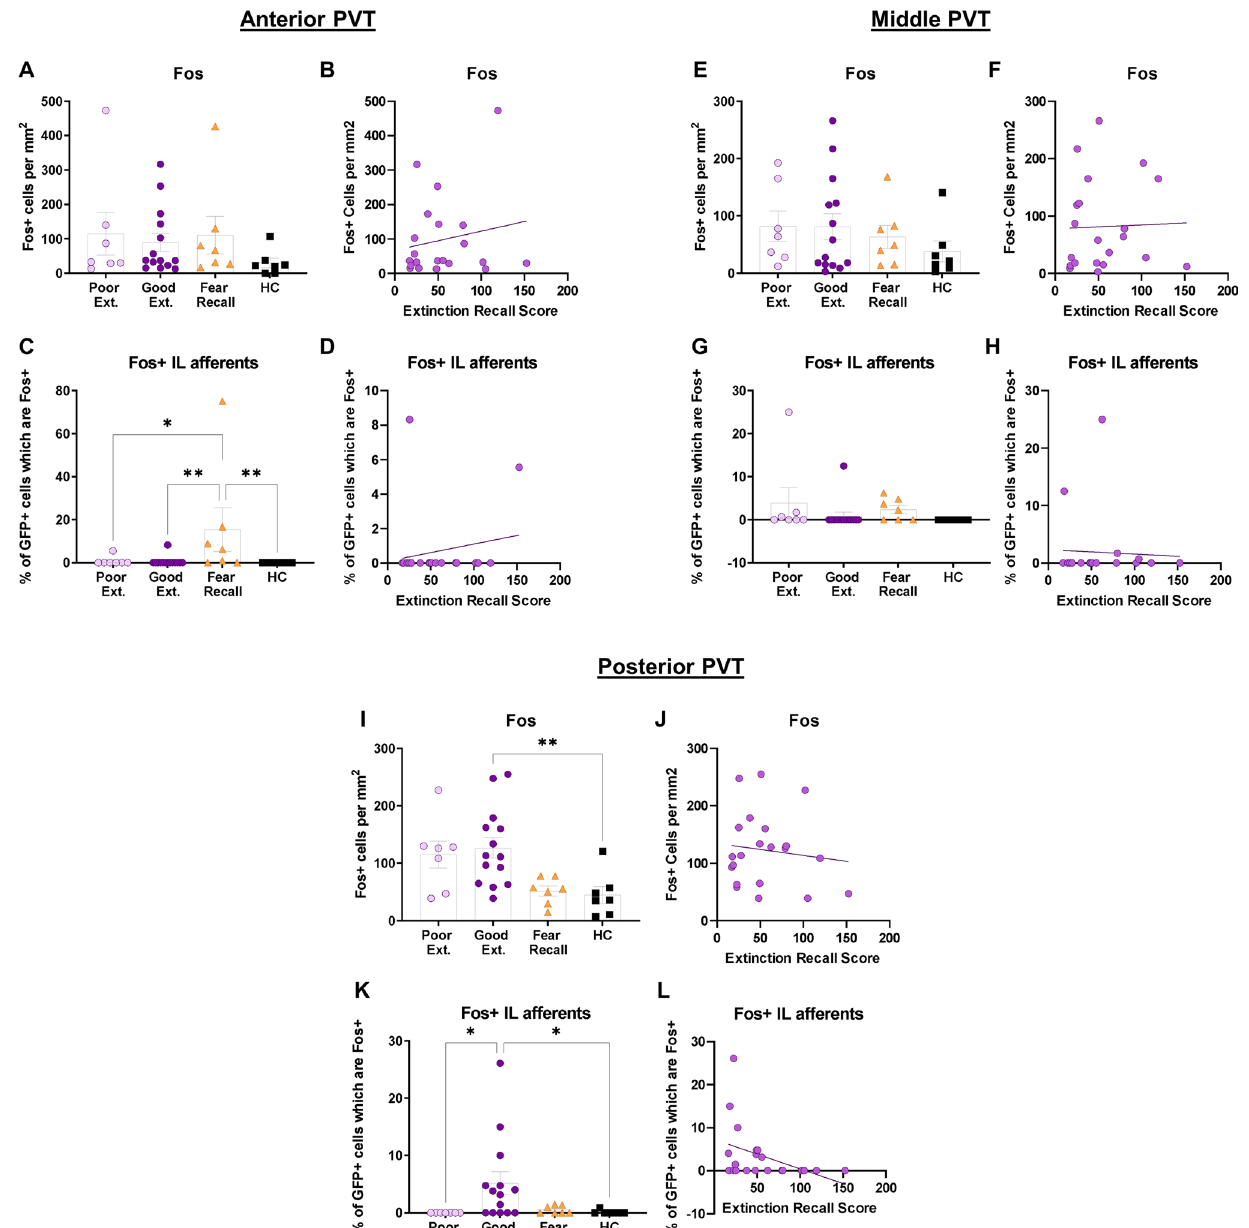
Figure 4. Fos activity is elevated in the IL-afferents of the posterior paraventricular thalamus (PVT) in rats displaying good extinction. ( A ) No significant differences among groups in Fos expression in the aPVT. ( B ) No significant correlation between Fos expression and extinction recall in the aPVT. ( C ) Fear recall group showed elevated Fos expression within IL-afferents relative to all other groups. ( D ) No significant correlation between Fos expression within IL-afferents and extinction recall in the aPVT. ( E ) No significant differences among groups in Fos expression in the mPVT. ( F ) No significant correlation between Fos expression and extinction recall in the mPVT. ( G ) No significant differences among groups in Fos expression within IL-afferents in the mPVT. ( H ) No significant correlation between Fos expression within IL-afferents and extinction recall in the mPVT. ( I ) Good extinction group, but no other groups, shows elevated Fos activity in the pPVT relative to the home cage group. ( J ) No significant correlation between Fos expression and extinction recall in the pPVT. ( K ) Good extinction group shows elevated Fos expression in IL-afferents relative to the poor extinction group and the home cage group. ( L ) Significant correlation between Fos expression within IL-afferents and extinction recall such that good extinction recall is related to more Fos expression within IL-afferents. Error bars represent standard error of the mean. * p < 0.05, ** p <